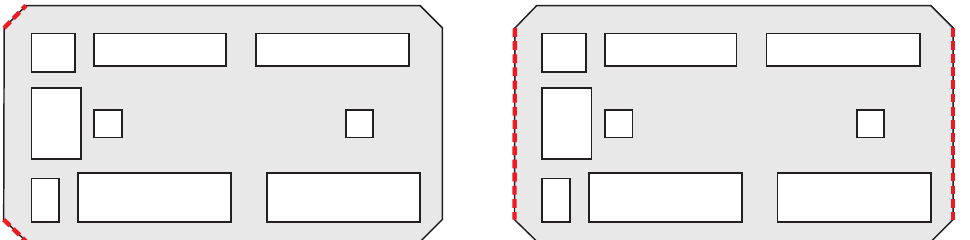
Figure 4. Admissible parts Γ ad (marked with dashed red lines) of the boundary Γ where exit doors can be located for the first case ( left ) and for the second one ( right